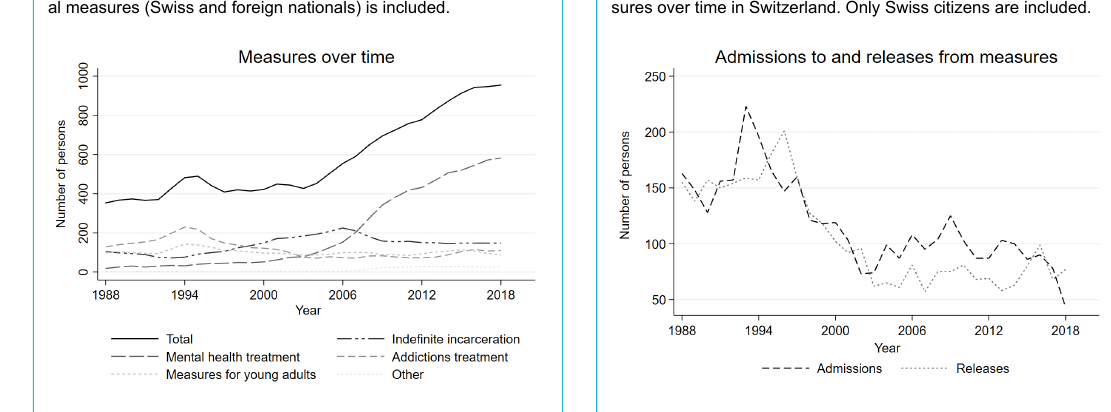
Figure S1: Number of persons in custodial measures by type of measure over time in Switzerland. The entire population in custodi- al measures (Swiss and foreign nationals) is included.